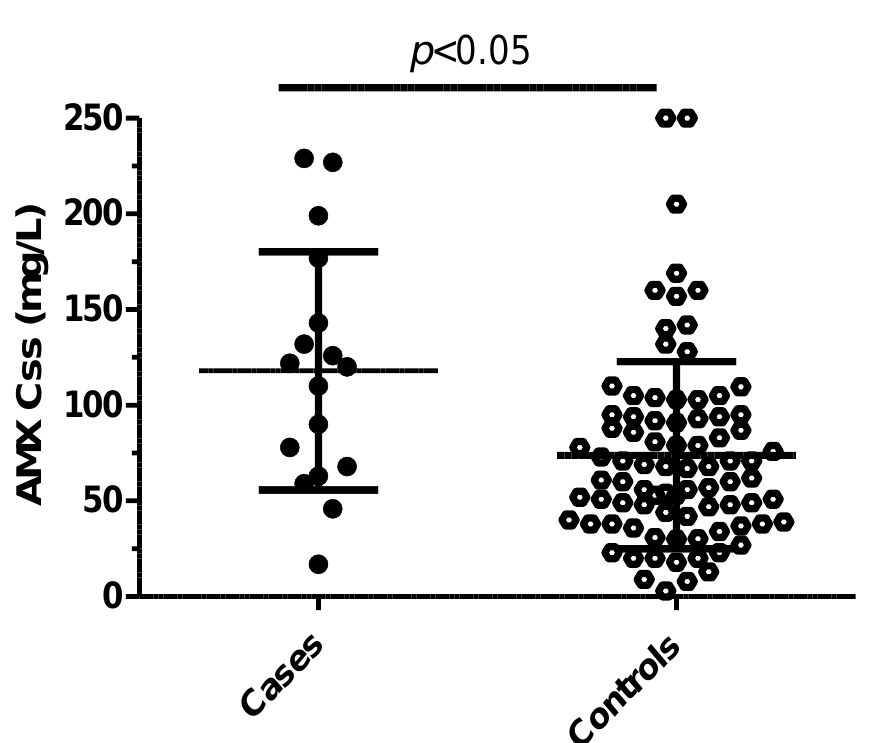
Figure 2. Scatter dot plot of amoxicillin steady-state concentrations (mg/L) for patients with neuro- toxicity attributed (cases, n = 17) and non-attributed (controls n = 84) to amoxicillin. Horizontal solid lines are the mean ± standard deviation (sd) concentrations.